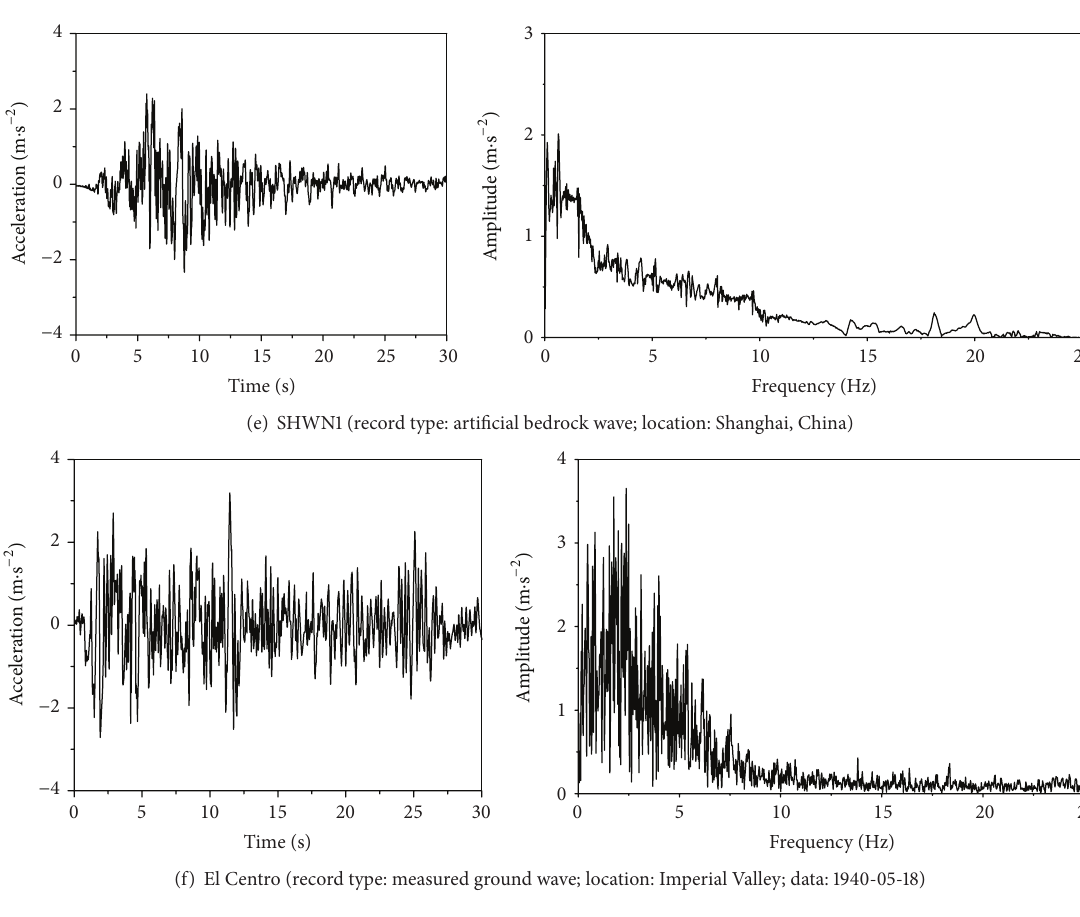
Figure 7: Seismic wave data.